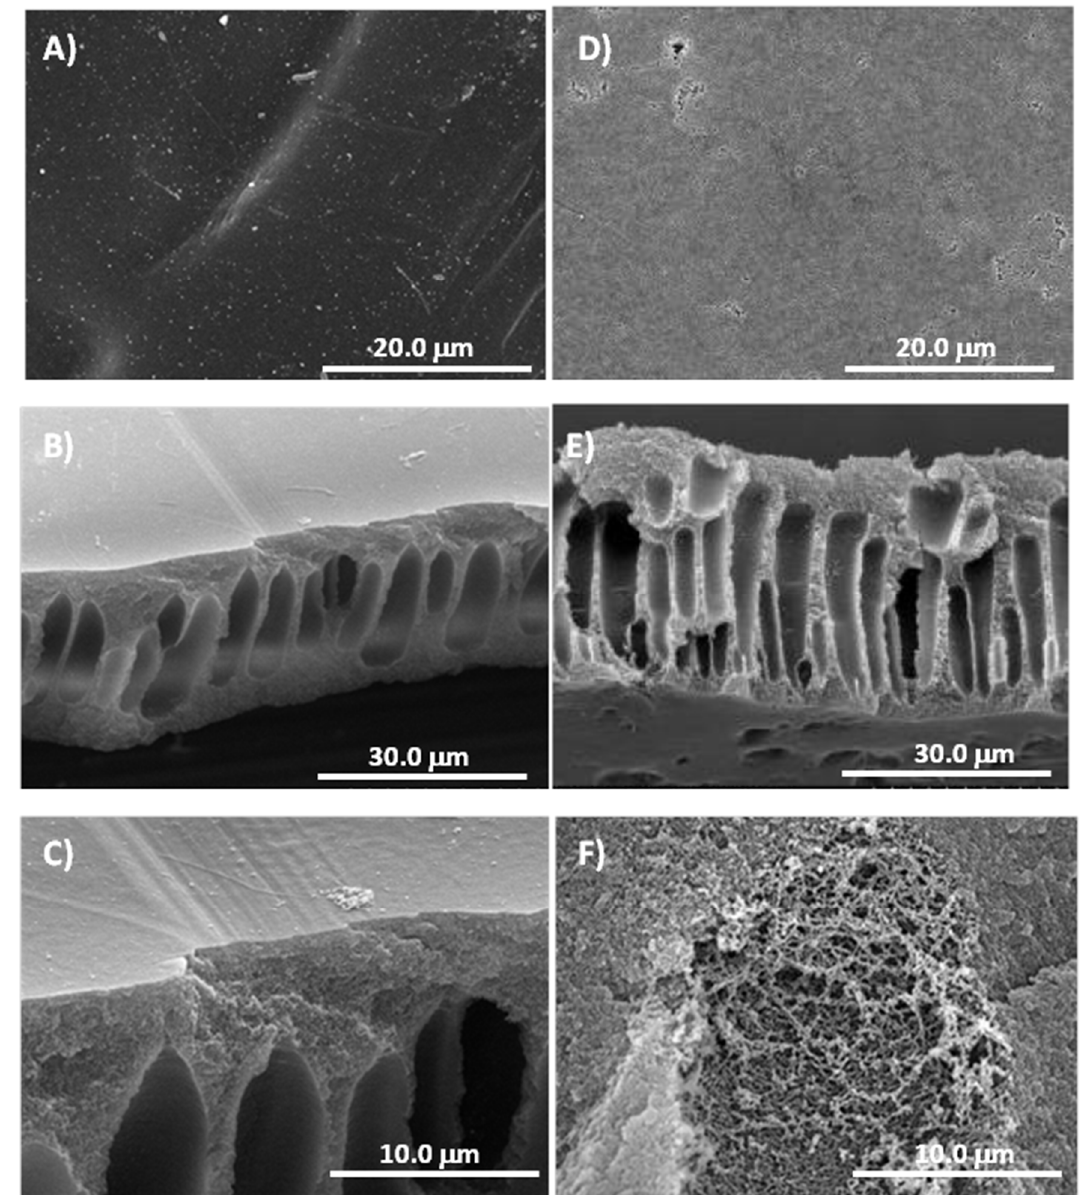
Figure 4. SEM images of PAN membrane ( A ) untreated surface × 2.5 k, ( B ) untreated cross-section × 1.5 k, ( C ) amplified untreated cross-section × 5.0 k and hydrolyzed during 1.5 h × 1.5 k, ( D ) surface × 2.5 k, ( E ) cross-section × 1.5 k, and ( F ) amplified hydrolyzed cross-section × 4.5